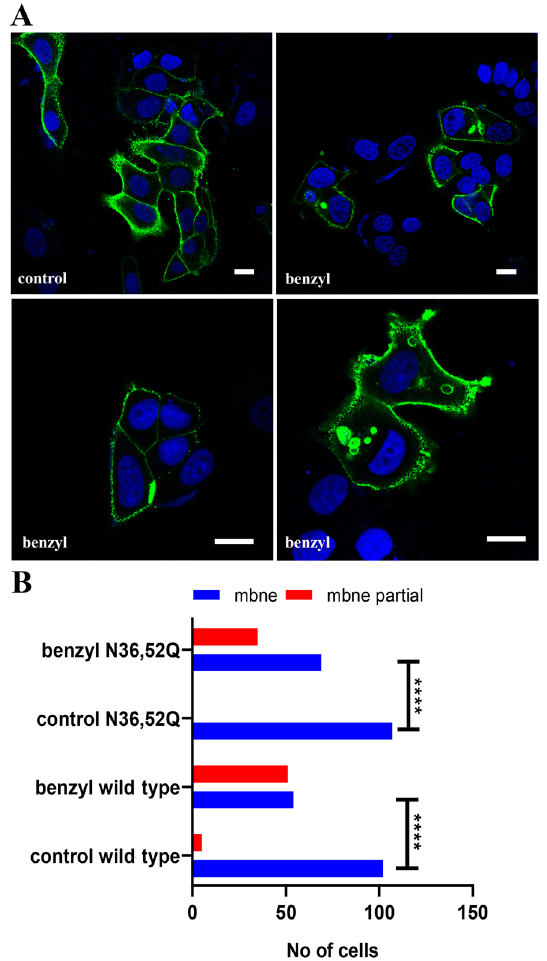
Figure 6. Effect of benzyl- α -GalNAc on subcellular localization of CD24 in MCF-7 cells. ( A ) Rep- resentative combined images of cells stained with anti-flag and topro showing localization of wild type (ER-tag) CD24 in transfected control (control) and cells treated with 5 mM benzyl- α -GalNAc for 48 h (benzyl). Scale bars, 10 µ m. ( B ) Diagram presenting absolute number of cells with complete (mbne) or partial (mbne partial) localization of CD24 following transfection with wild type (ER-tag) and double N36, 52Q mutant in absence (control) and presence of 5 mM benzyl- α -GalNAc for 72 h. Statistical significance (****) for p < 0.0001 with t -test.